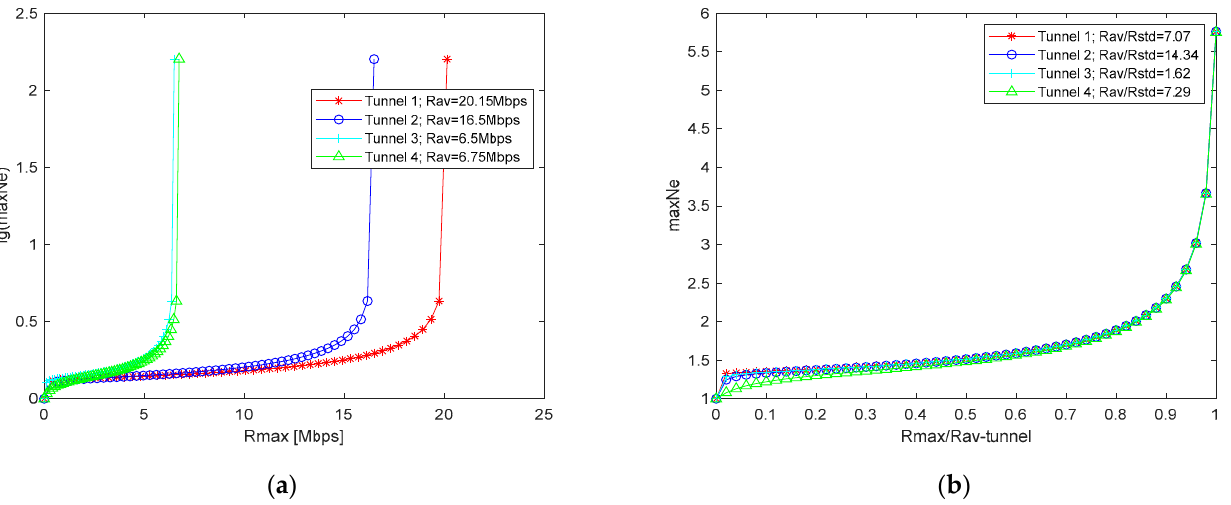
Figure 12. Price of anarchy, max NE , for the simulated virtual tunnels. ( a ) max NE versus the absolute total rate R max ; ( b ) max NE versus the relative total rate R max /R av-tunnel .